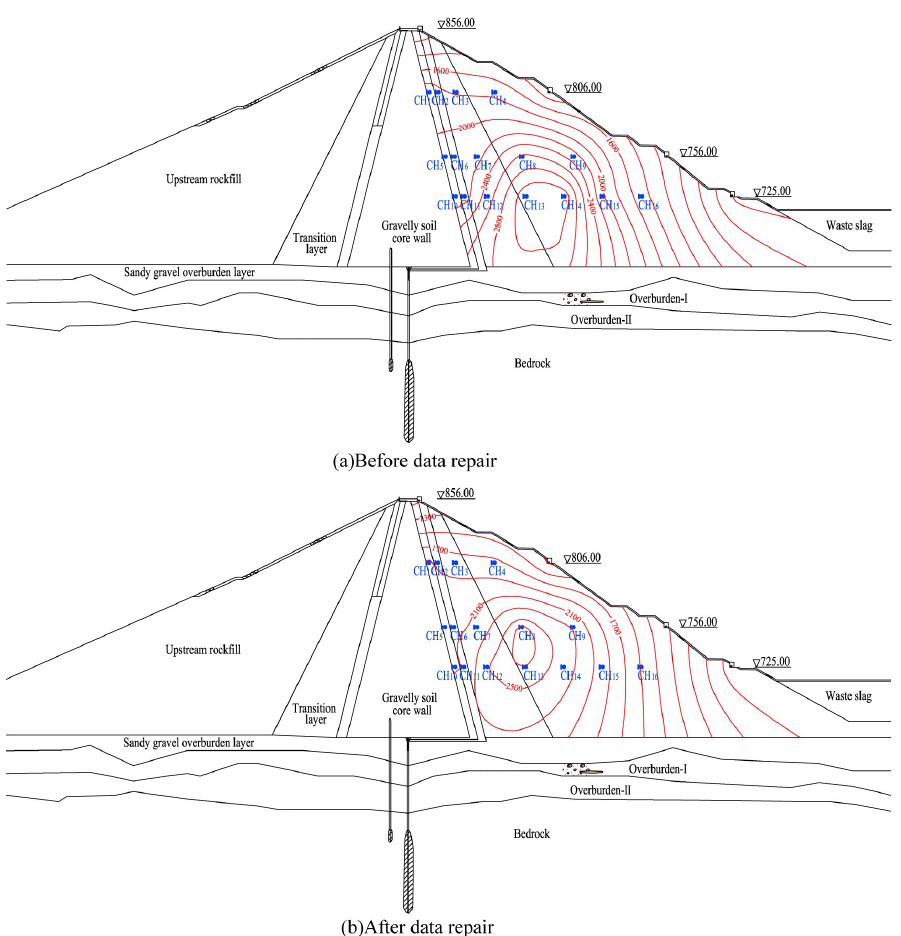
Figure 13. Isoline map of the internal settlement deformation of the dam at profile 0+240 m (12 October 2017).